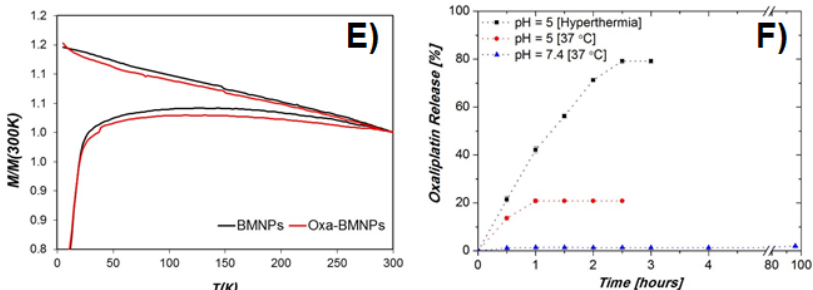
Figure 2. ( A ) Adsorption kinetics and ( B ) adsorption isotherm of oxaliplatin (Oxa) on BMNPs. The line